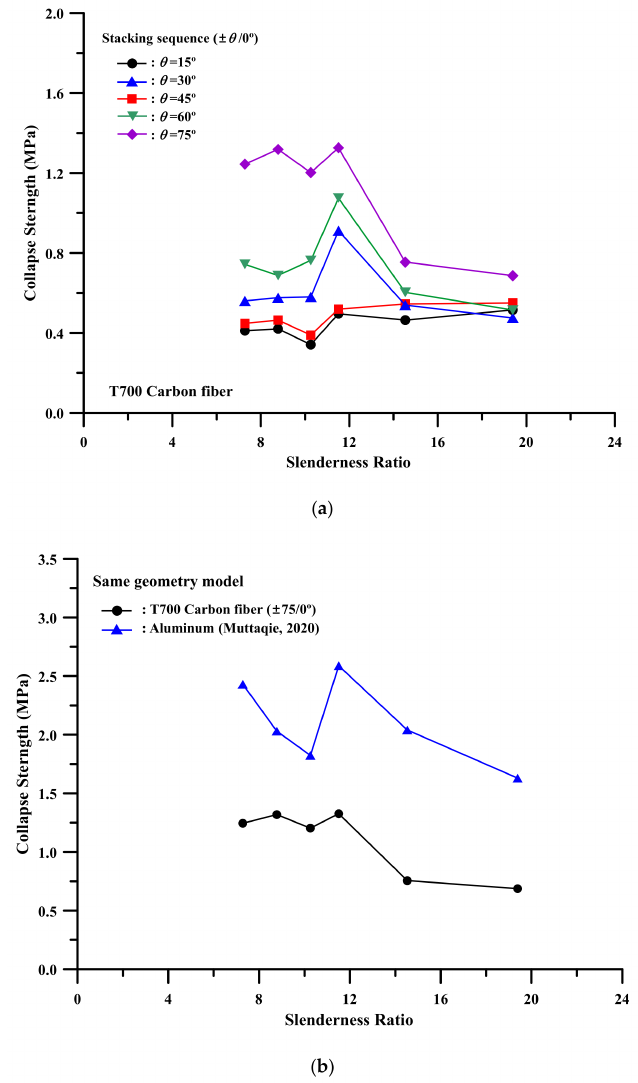
Figure 9. Collapse strength comparison depending on stacking angle or material with identical geometry. ( a ) Variation in composite material with stacking angle, ( b ) Comparison between aluminum and composite material of ±